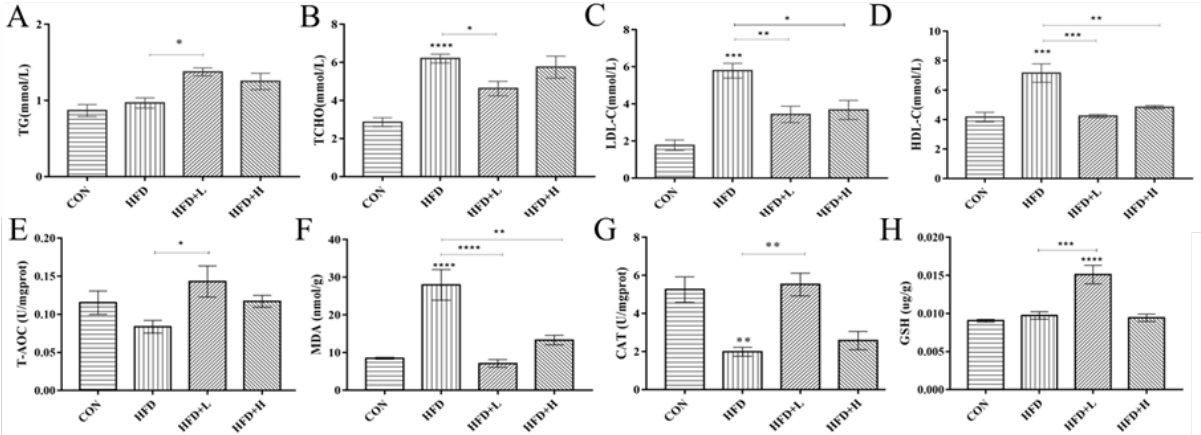
Figure 4. Effect of CIP on antioxidant activity in liver and serum lipid levels in HFD-fed mice ( n = 5). ( A ) TG, ( B ) TCHO, ( C ) LDL-c, and ( D ) HDL-c in serum and ( E ) T-AOC, ( F ) MDA, ( G ) CAT, and ( H ) GSH in the liver of HFD-fed mice. Data were shown as mean ± SEM. * p < 0.05, ** p < 0.005, *** p < 0.001, and **** p < 0.0001 compared with the other groups.